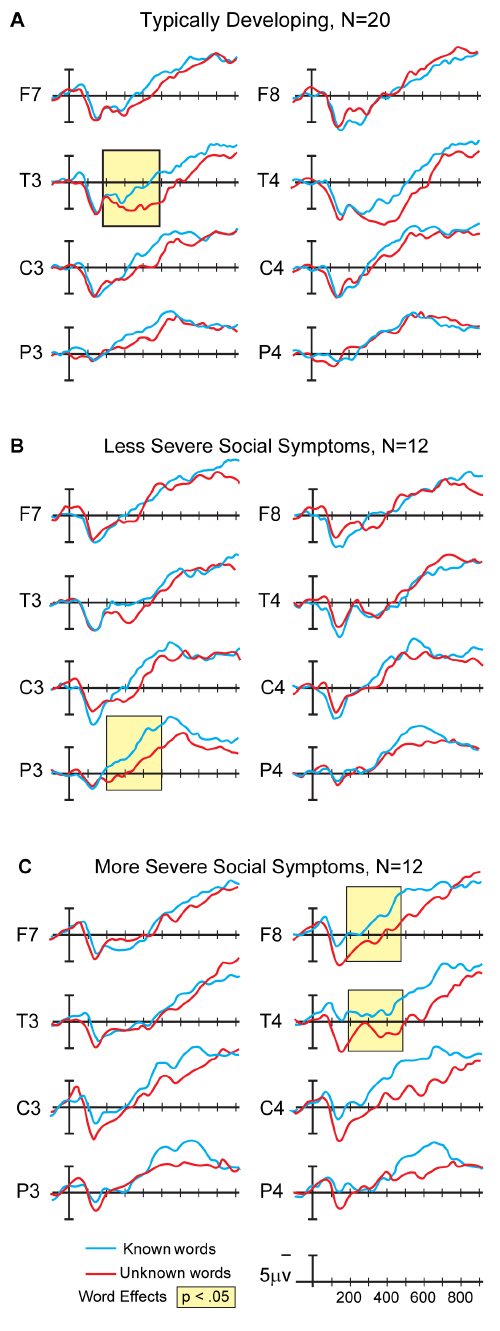
Figure 1. Time 1 ERP waveforms. (A) TD 2-year-olds exhibit a focal response with significant differences between known and unknown words only at the left temporal electrode site T3, (B) children with ASD exhibiting less severe social symptoms show a more typical ERP pattern with a focal response that is significant only at the left parietal electrode site P3, (C) affected children exhibiting more severe social symptoms show a more diffuse response in the right hemisphere.